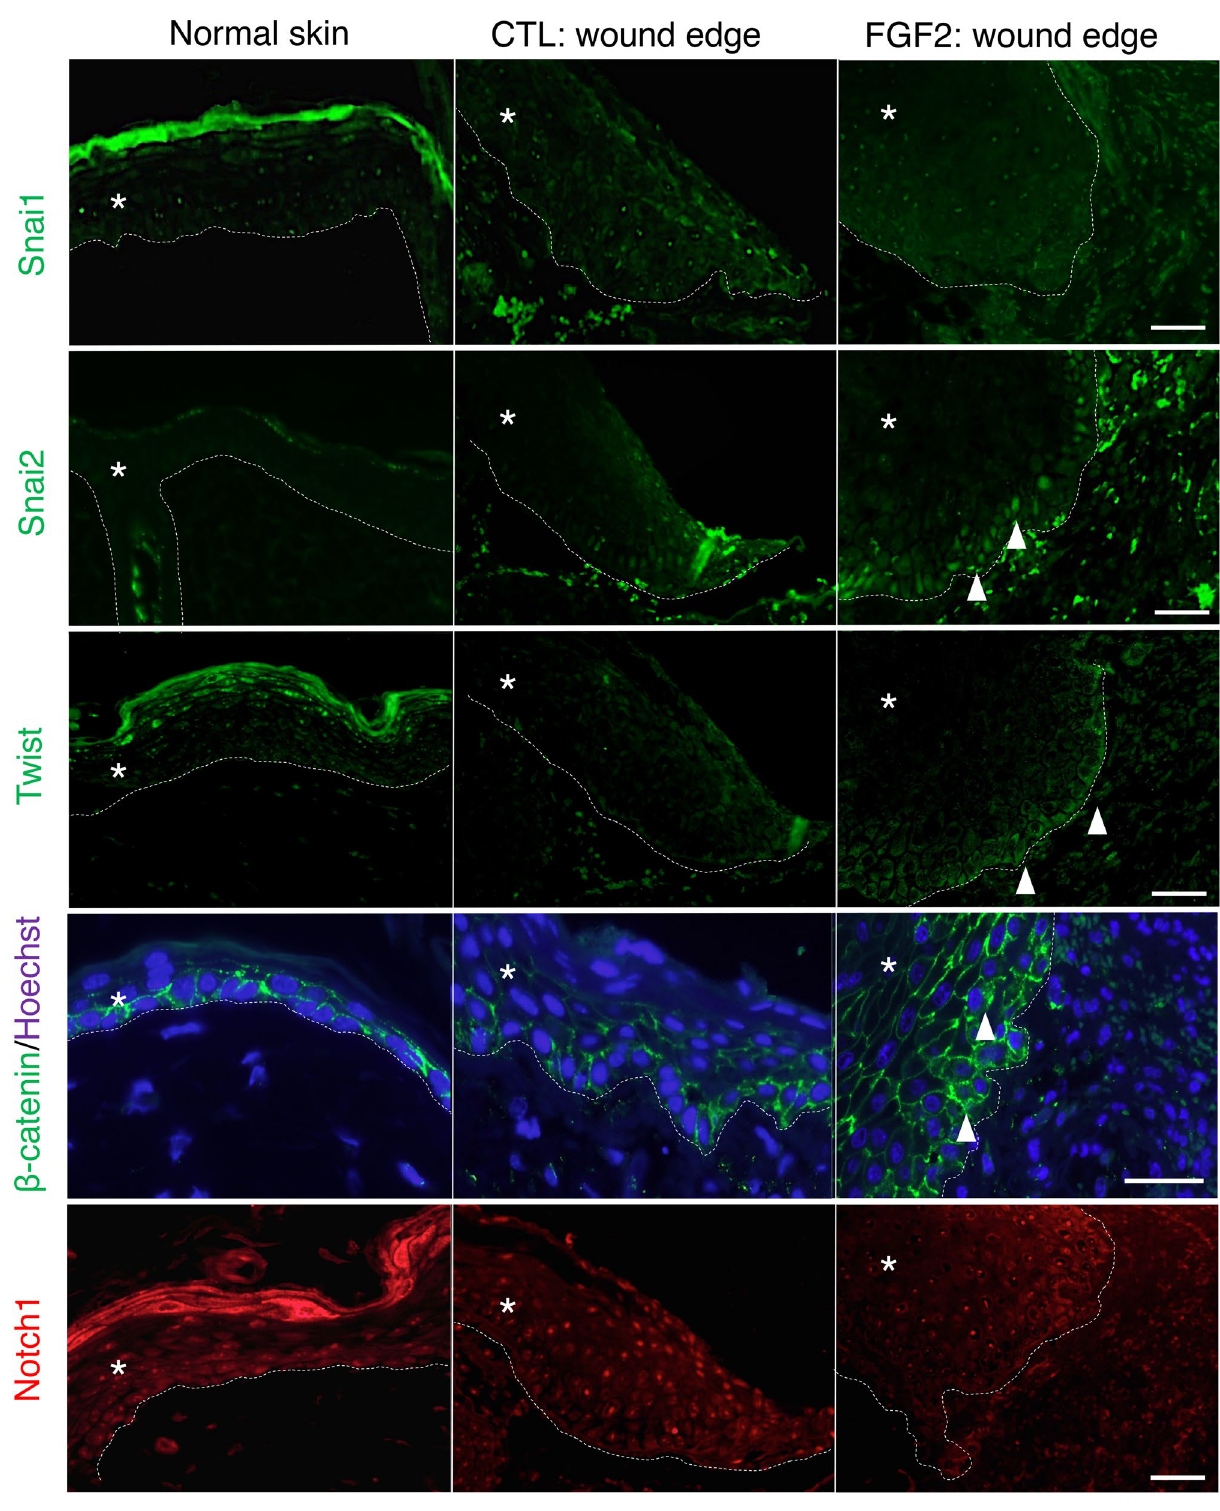
Figure 5. Immunofluorescent staining for EMT associated transcriptional factors was performed on non- injured skin (normal skin) and wound edges treated with vehicle (CTL) and FGF2 4 days after wounding. Snai1 was absent in all normal skin, CTL wounds, and FGF2-treated wounds. Snai2 was robustly expressed in wound edge keratinocytes in FGF2-treated wounds (arrowheads) and faintly expressed in those in control wounds. Twist was expressed in FGF2-treated wounds (arrowheads). β-catenin translocated from the cell membrane to the cytoplasm or nuclei (arrowheads) in the wound tissues, especially in the FGF2-treated group. Notch1 did not differ among samples. Scale bar: 40 μm, *shows